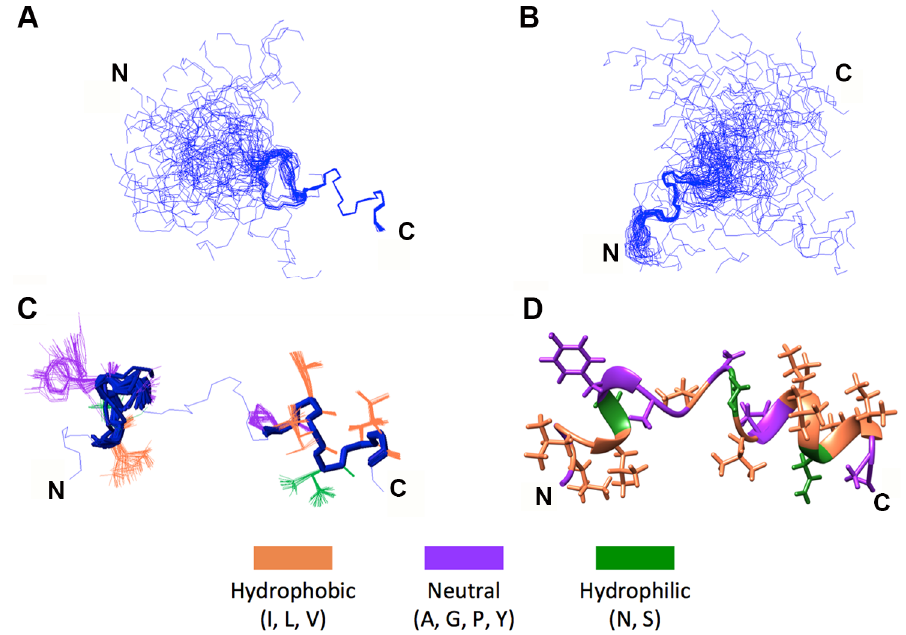
Fig 3. NMR structural determination of a helix-loop-helix conformation in p15HPpep. (A) Ensemble of the 50 lowest energy structures (out of 100 calculated) of wt p15HPpep with the C-terminal P81-I86 helix superposed. (B) Ensemble of the 50 lowest energy structures with the N-terminal L70-G74 helix superposed. (C) Backbone superposition of the two terminal p15HPpep helices (L70-G74 and P81-I86) of all 50 ensemble members onto the lowest-energy conformer. (D) Lowest energy conformer of the wt p15HPpep. In this conformer, the α -helical segments span residues L71-G74 and P81-I86 at the termini, connected by an unstructured turn/loop. Residues in panels C and D are color-coded as